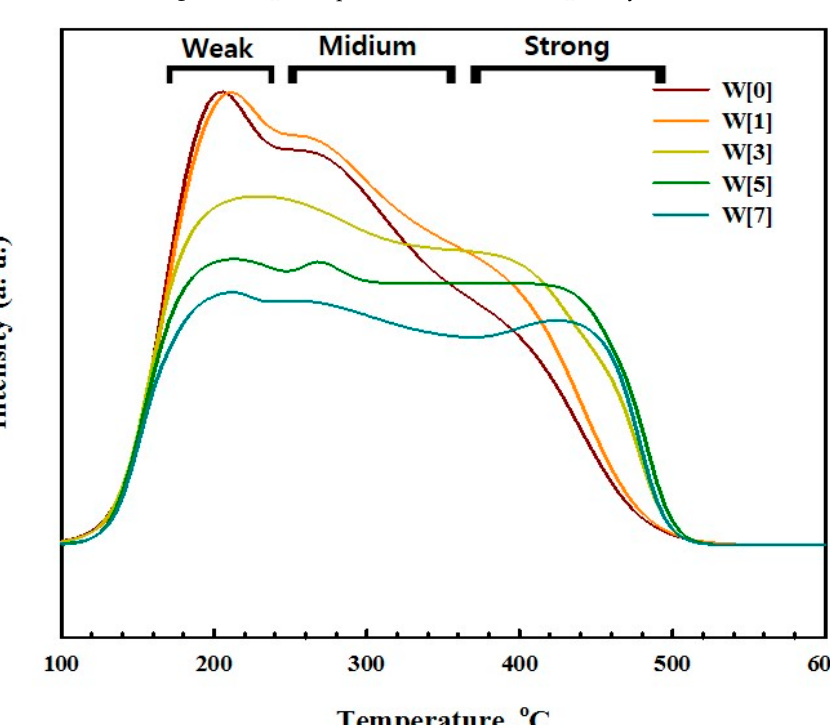
Figure 5. NH 3 -TPD profiles of Pt–W[x]/TiO 2 catalysts. Table 4. Density of acid sites on Pt–W[x]/TiO 2 catalysts as determined by NH 3 -TPD analysis.